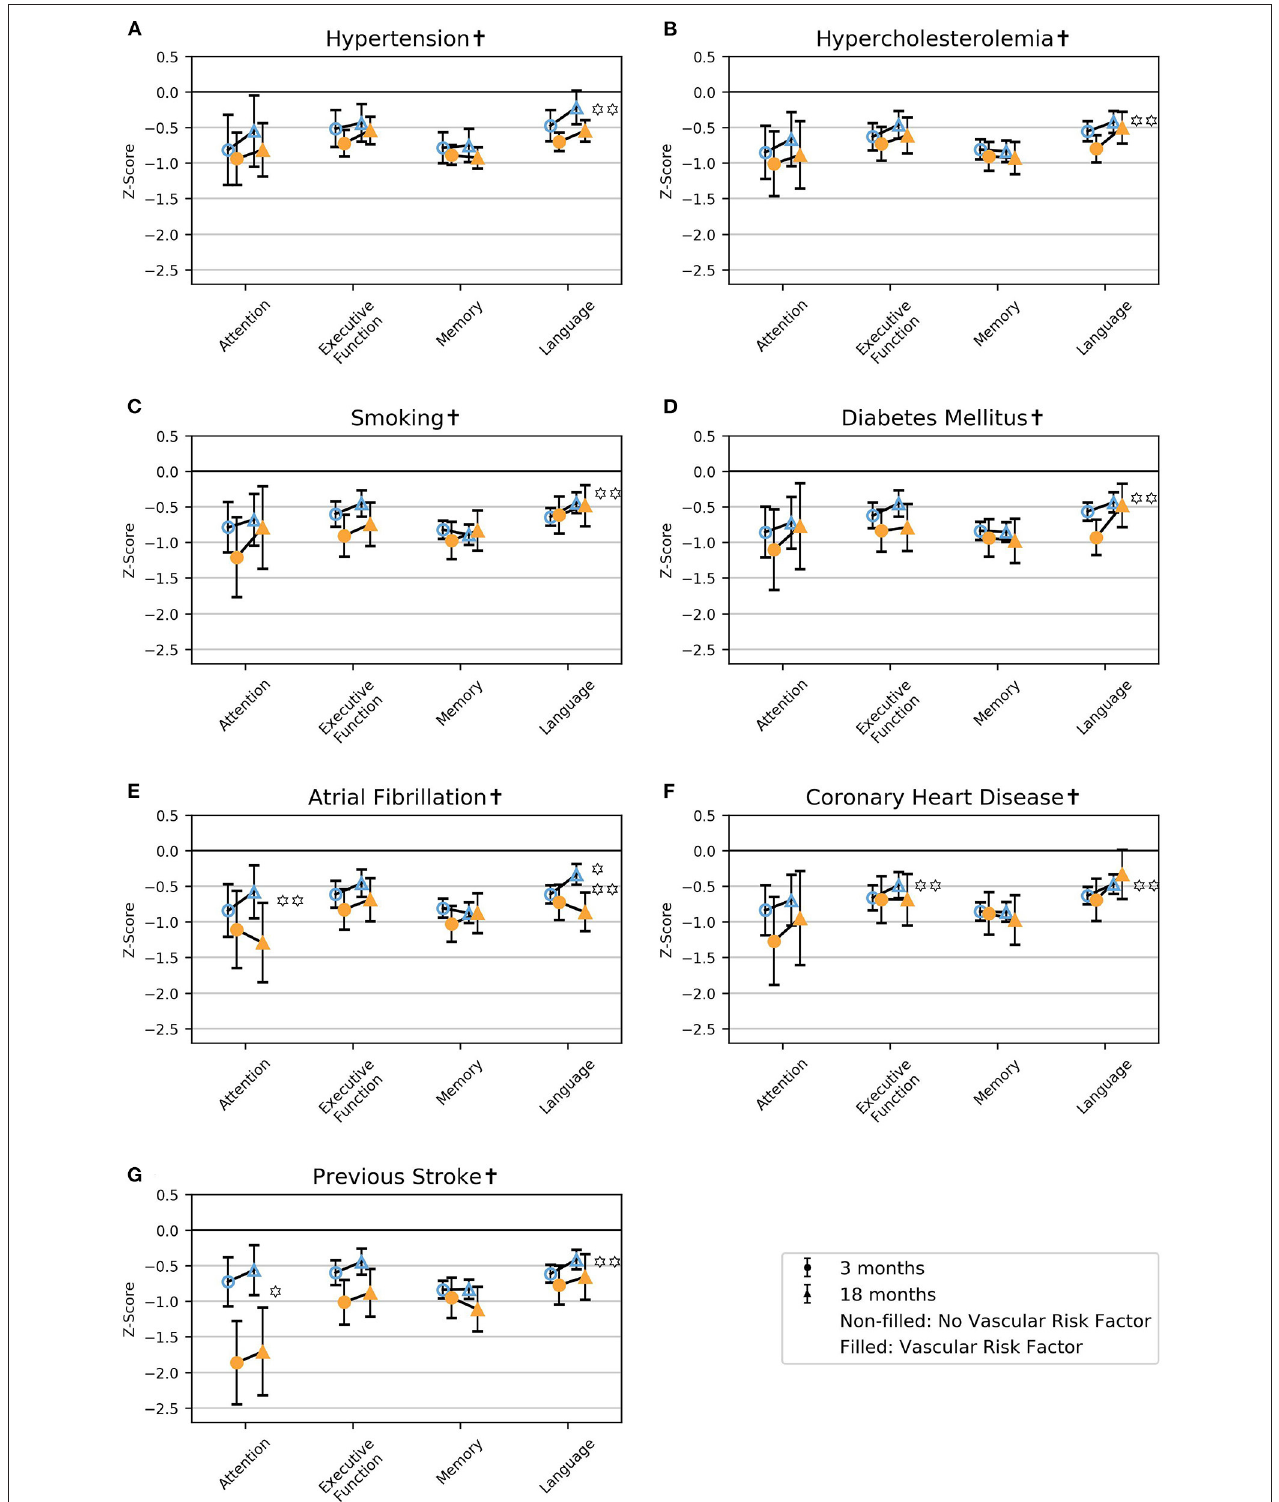
FIGURE 3 | Mean z-score with 95% CI for the cognitive domains for the different vascular risk factors at 3 and 18 months post-stroke in model 1. (A) hypertension, (B) hypercholesterolemia, (C) smoking, (D) diabetes mellitus, (E) atrial fibrillation, (F) coronary heart disease, (G) previous stroke. †Adjusted for age, education, and sex. p < 0.01 for LRvasc χ 2 (2) = likelihood ratio test model 1 vs. model 2, with two degrees of freedom; hypothesis test of whether there is an effect of the vascular risk factor. p < 0.01 LRtime χ 2 (2) = likelihood ratio test model 1 vs. model 2, with two degrees of freedom; hypothesis test of whether there is an effect of follow-up